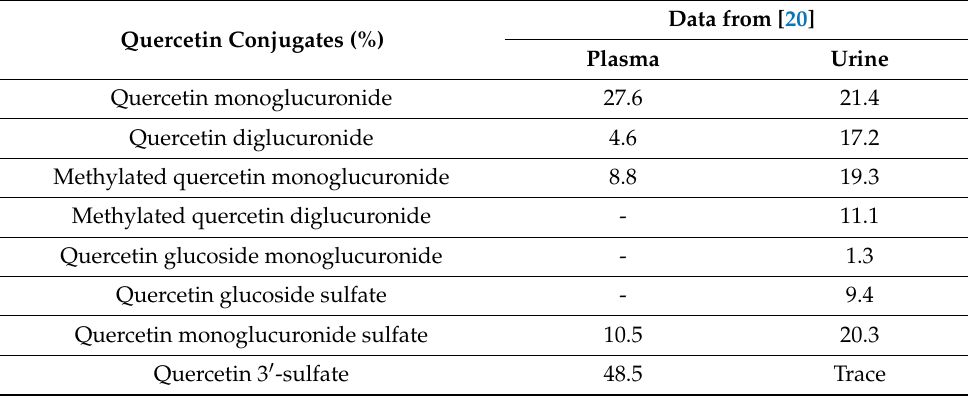
Table 2. Percentage of quercetin metabolites localized in human plasma and urine after an enriched diet of quercetin derivatives. Data from